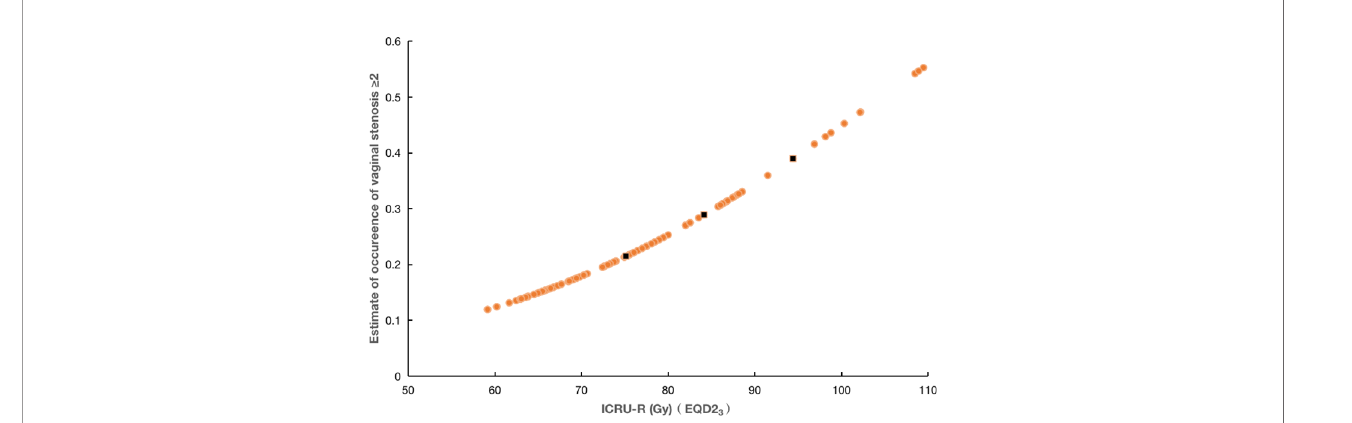
FIGURE 3 | The relationship of dose – effect of the combined brachytherapy and EBRT dose to ICRU-R point in EQD2 and VS G ≥ 2 in (N = 351) patients. Three black points represent ICRU-R point doses of 75, 85, and 95 Gy,